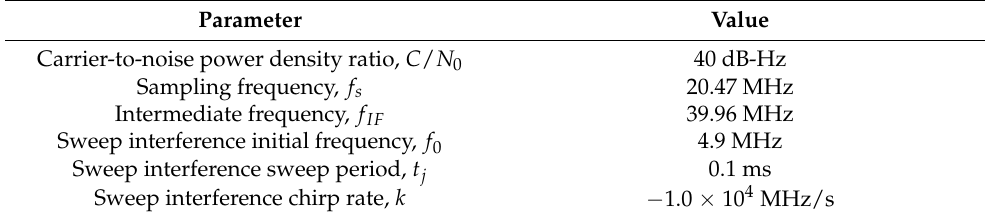
Table 1. The experimental setting parameters in the GNSS interference